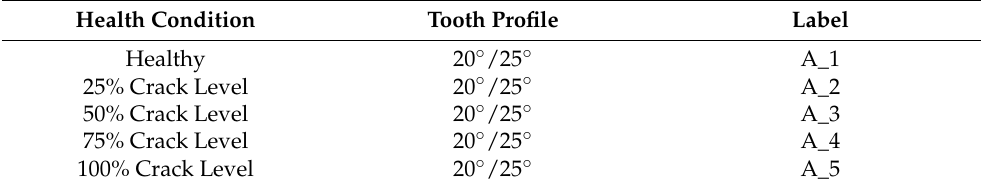
Table 5. The classes identified for 20 ◦ /25 ◦ profiled asymmetric gears. Health Condition Tooth Profile